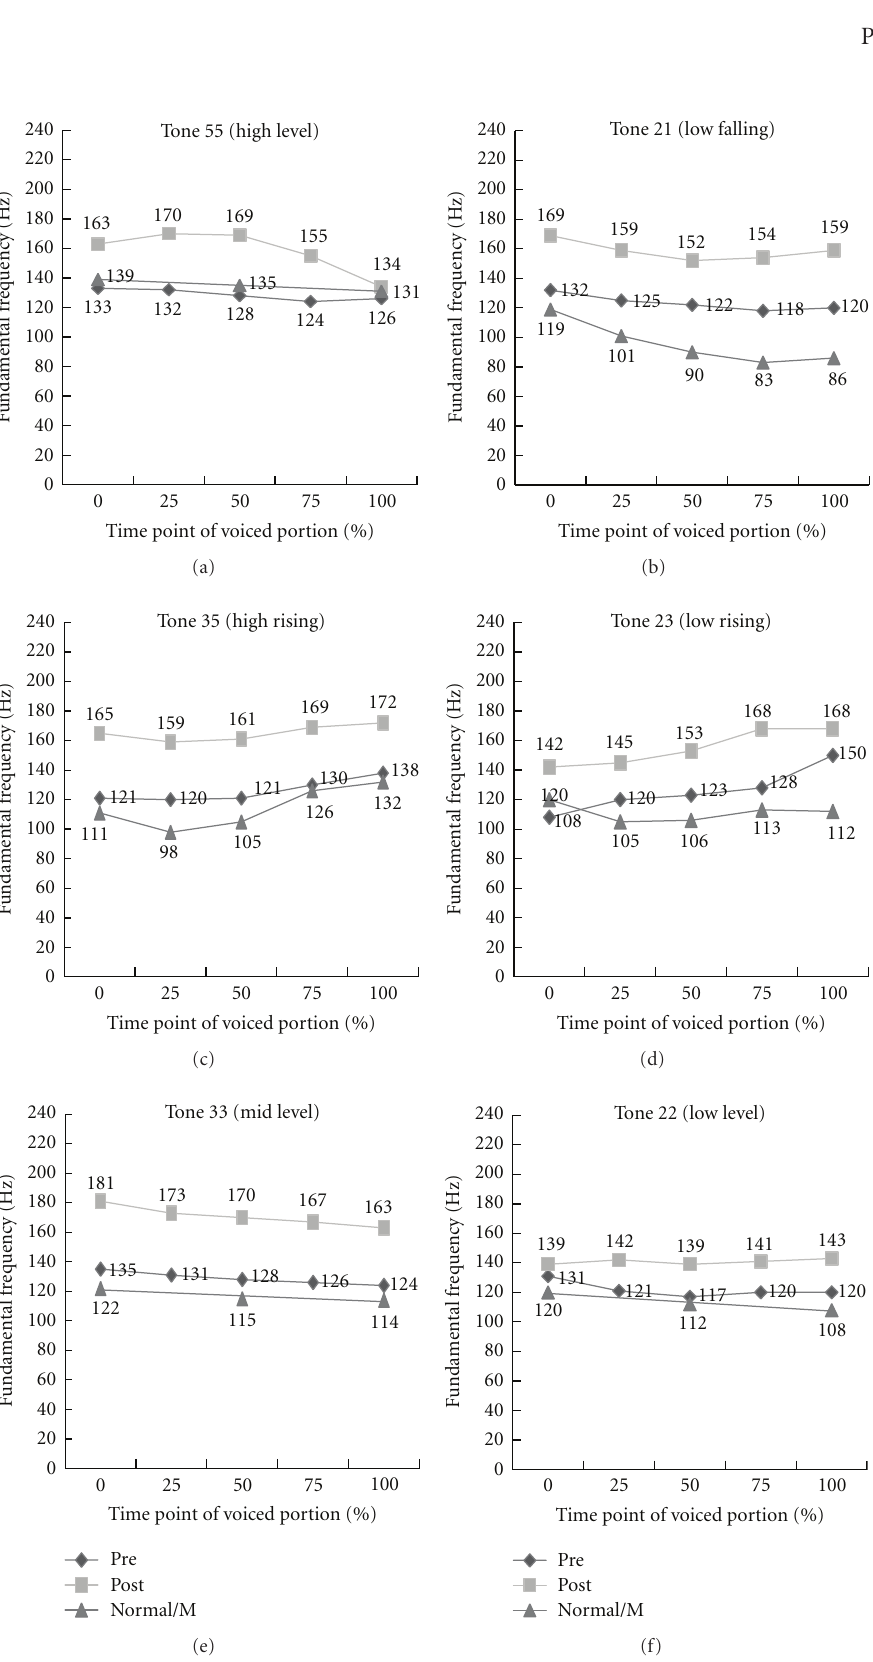
Figure 2: F0 pattern of six lexical tones produced by a 60-year-old male, WSH. The normative data are from Whitehill et al. [21, 22], cited in Whitehill and Wong